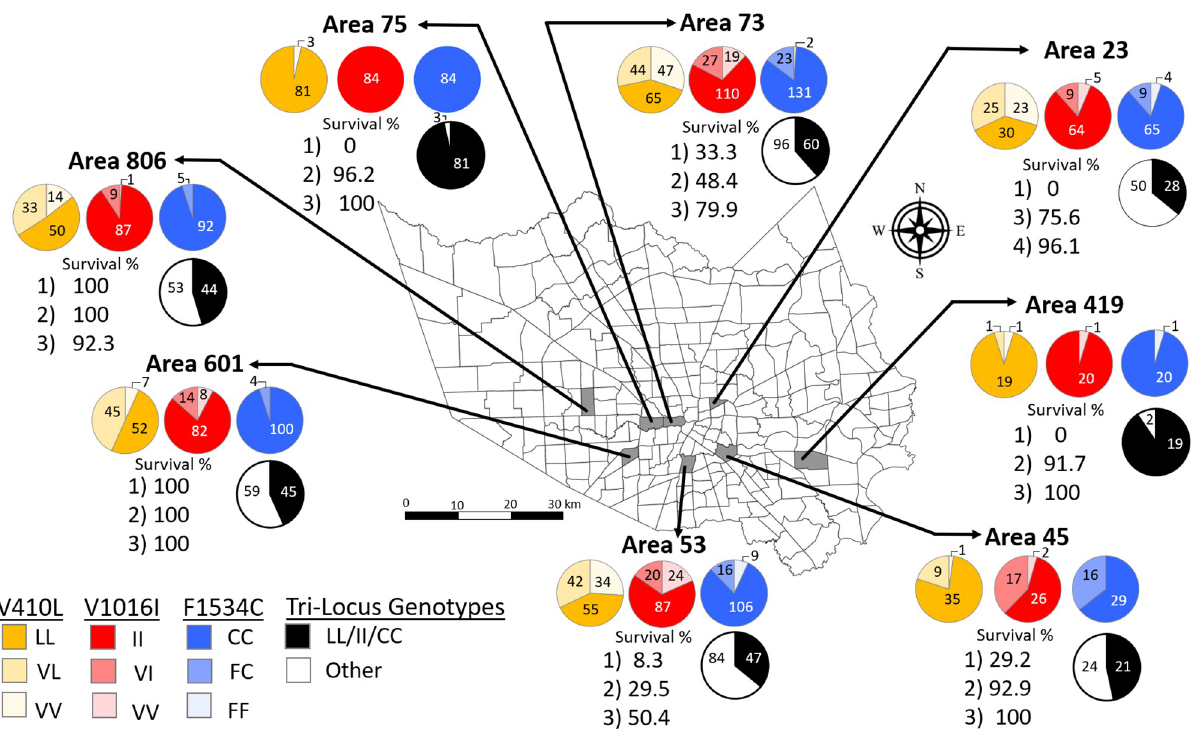
Fig 1. Proportion of kdr mutations in female mosquitoes shown by operational control area in Harris County. The pie charts represent the genotypic frequencies for each of the kdr mutations detected in individual females of Ae . aegypti collected for the eight operational areas in Harris County, adapted from Hernandez et al. [21]. Proportions of the genotypes at the 410 site are in shades of yellow (LL, VL, VV), and those for the 1016 (II, VI, VV) and 1534 (CC, FC, FF) sites previously genotyped are represented by shades of red and blue, respectively. In each pie chart, the lightest color intensity represents the wild-type, susceptible genotypes (410 VV; 1016 VV; or 1534 FF) and the darkest color indicates the resistant genotype (410 LL; 1016 II; 1534 CC), with the intermediate color intensities corresponding to the heterozygotes (410 VL; 1016 VI; 1534 FC). For each area, the proportion of tri-locus homozygous resistant (LL/II/CC) females is shown in black, while the proportion of all other tri-locus genotypes at the 410, 1016, and 1534 genotypes are in white. The number of genotypes per area is indicated on the corresponding color on each pie chart. Survivorship data (Survival %) for each area (shown in columns below pie charts) by distance from the spray application [1) 7.62, 2) 15.24, 3) 22.86, and 4) 38.1 m] was previously reported [21] but is shown here for clarity. Map source: edited in QGIS v.3.22.1 software (www.qgis.org). The layers for county (Map service: Harris County boundary masked) (https://www.arcgis.com/home/item.html?id=a8aa2ef4067348c79ccea62857a2f623) and for Harris County operational area boundaries (MVCDOperational_Areas) (https://www.arcgis.com/home/item.html?id=87a4455991c146259cf6c2e2384e8b71) were created by Harris County Public Health and are publicly available. There are no special restrictions or limitations on the terms of use of the layers applied to this map.